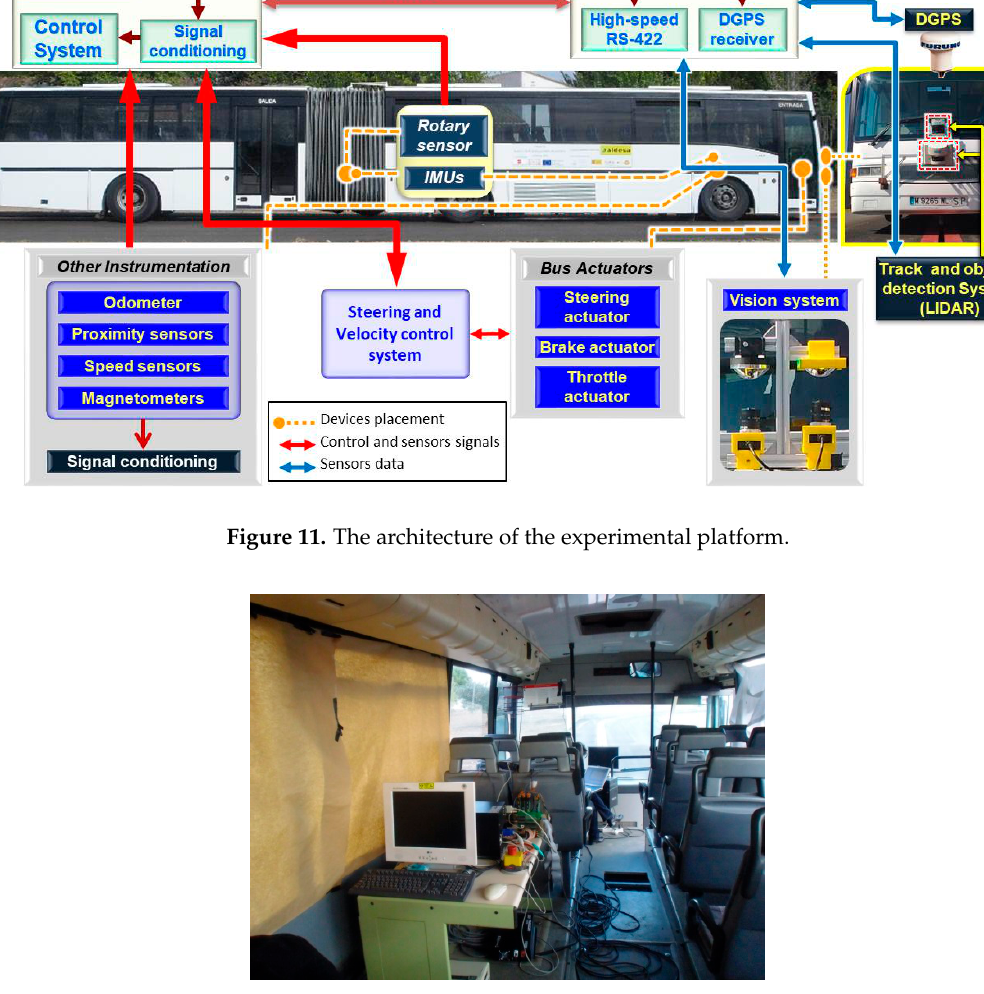
Figure 12. On-board instrumentation and control system of the experimental platform.